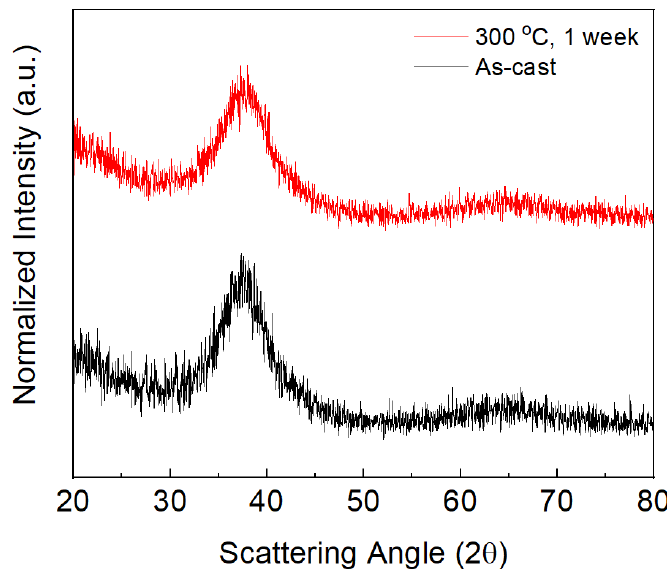
Figure 1. The XRD patterns for the as-cast and annealed Zr 52.5 Cu 17.9 Ni 14.6 Al 10 Ti 5 bulk metallic glass (BMG) samples.